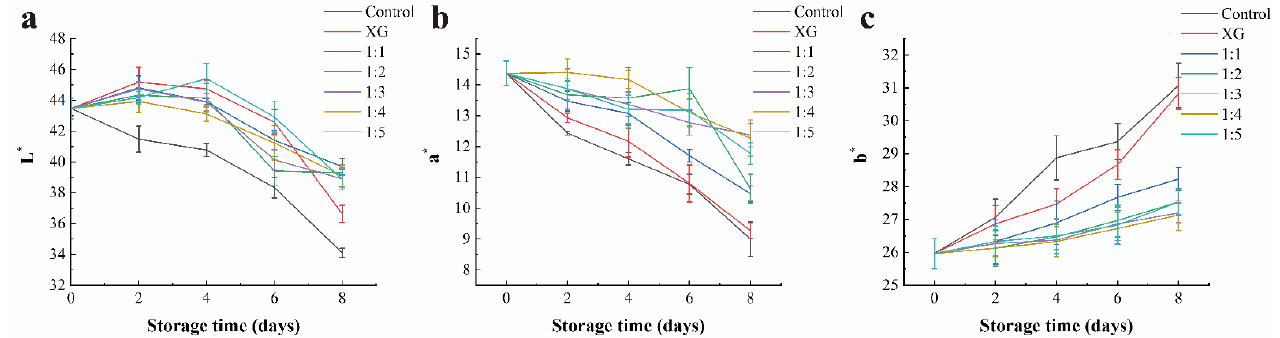
Figure 7. Changes in the color parameter value of salmon: L*(a), a*(b) and b*(c), respectively, during storage. Control = coated with distilled water; XG = coated with XG solution; 1:1 = coated with XG and liposome (1:1, v / v ) mixed solution; 1:2 = coated with XG and liposome (1:2, v / v ) mixed solution; 1:3 = coated with XG and liposome (1:3, v / v ) mixed solution; 1:4 = coated with XG and liposome (1:4, v / v ) mixed solution; 1:5 = coated with XG and liposome (1:5, v / v ) mixed solution. XG: xanthan gum.